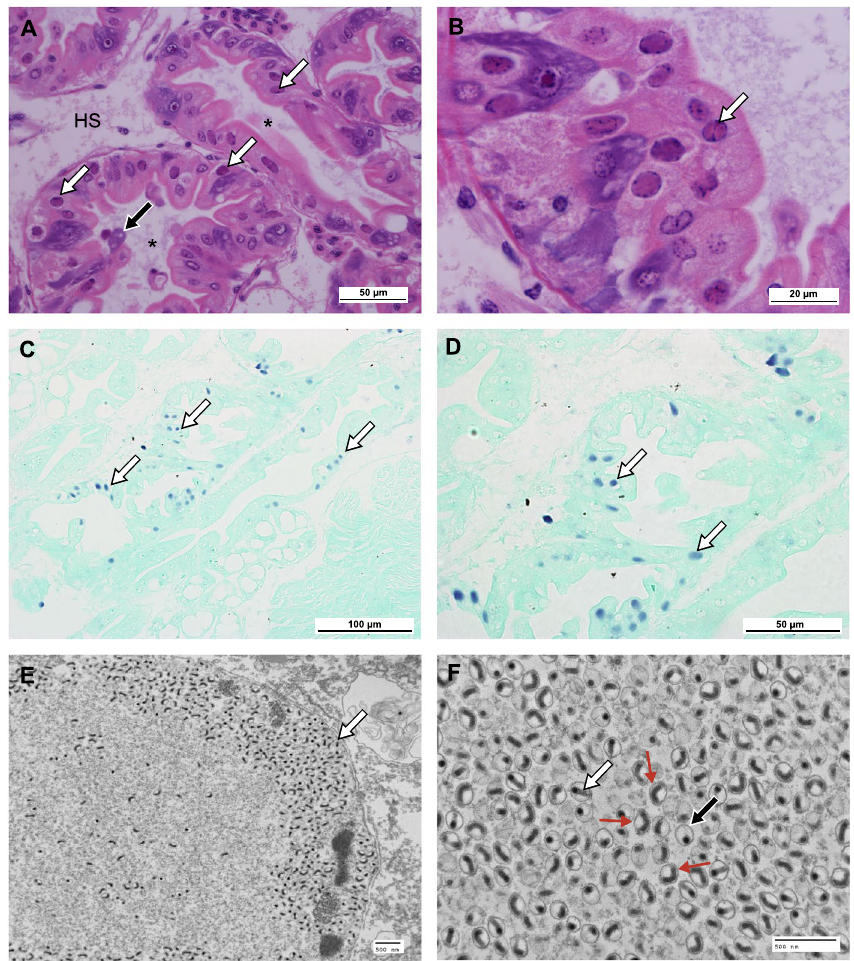
Figure 1. Homarus gammarus nudivirus (HgNV) infection within the hepatopancreas. ( A ) Section through the hepatopancreas, haemal sinus (HS) surrounds the tubules, cross section of the tubules shows a clear lumen ( * ). Infected nuclei within the epithelial cells of the tubules are enlarged, with emarginated chromatin and possess an eosinophilic inclusion body (white arrows). Infected cells (black arrow) may be sloughed into the lumen of the tubules. H&E Stain. Scale bar = 50 µ m. ( B ) Infections can be seen within multiple epithelial cells, infected nuclei appearing larger than uninfected nuclei. Margination of the chromatin can form septa leading to the appearance of discrete intranuclear compartmentalisation (arrow). H&E Stain. Scale bar = 20 µ m. ( C , D ) HgNV-specific DNA polymerase probe hybridised to infected nuclei (arrows) within epithelial cells of the hepatopancreas. In-situ hybridisation. Scale bar = 100 µ m, 50 µ m respectively. ( E ) Nucleus from a HgNV infected cell containing rod-shaped virions. Virions accumulate at the periphery of the nuclear membrane (arrow), TEM. Scale bar = 500 nm. ( F ) Longitudinal (white arrow) and transverse sections (black arrow) of HgNV virions within the nucleus. Virions possess an electron dense nucleocapsid surrounded by a trilaminar membrane (envelope). The rod shaped nucleocapsid appears to bend within the envelope forming a “u” or “v” shape in some cases (line arrows). TEM. Scale bar = 500